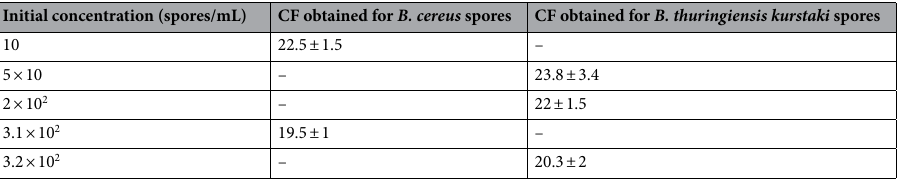
Table 3. Concentration factors of B. thuringiensis kurstaki and B. cereus spores for weakly contaminated saline water suspensions obtained with the FG filter.